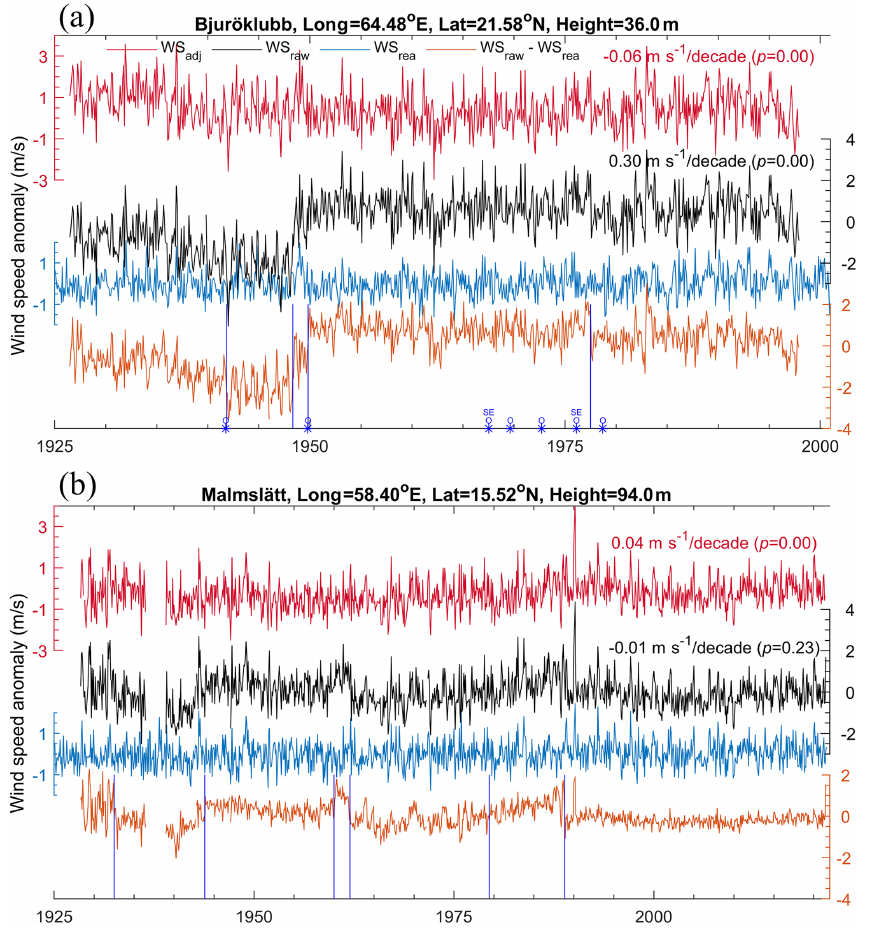
Figure 4. Two examples to illustrate the homogenization process and result. Black, blue, and red lines are raw (WS raw ), reanalysis (WS rea ), and adjusted (WS adj ) series of monthly wind speed anomaly, respectively. The brown line is the residual (raw series minus reanalysis series: WS raw –WS rea , calculated by linear regression) used for removing the natural climate variability from the raw series, which then amplifies spurious discontinuities during the homogenization. The reanalysis reference series was estimated from the climate reanalysis CERA-20C (1925–2010) and extended by the latest ERA5 (2011–2021). Blue vertical lines show the detected change-point dates, and blue asterisks show the changes in the events recorded in the collected metadata; for example, “O” represents a change in the observatory and “SE” shows changes in the surrounding environments. The long-term trends in wind speed are shown in the top